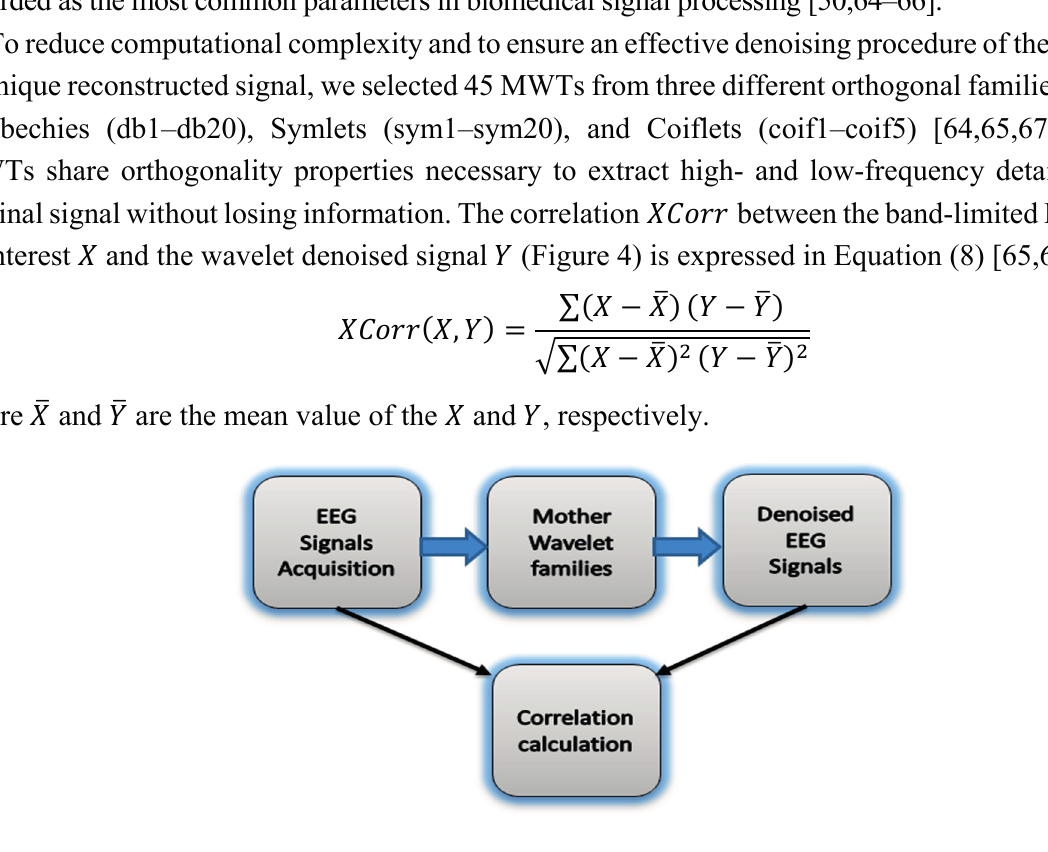
Figure 4. The block diagram of the correlation between the noisy EEG signals and denoised EEG signals using mother wavelet